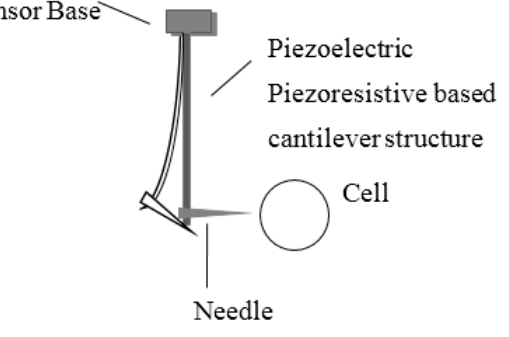
Figure 1. Typical probe based micro-force sensor.